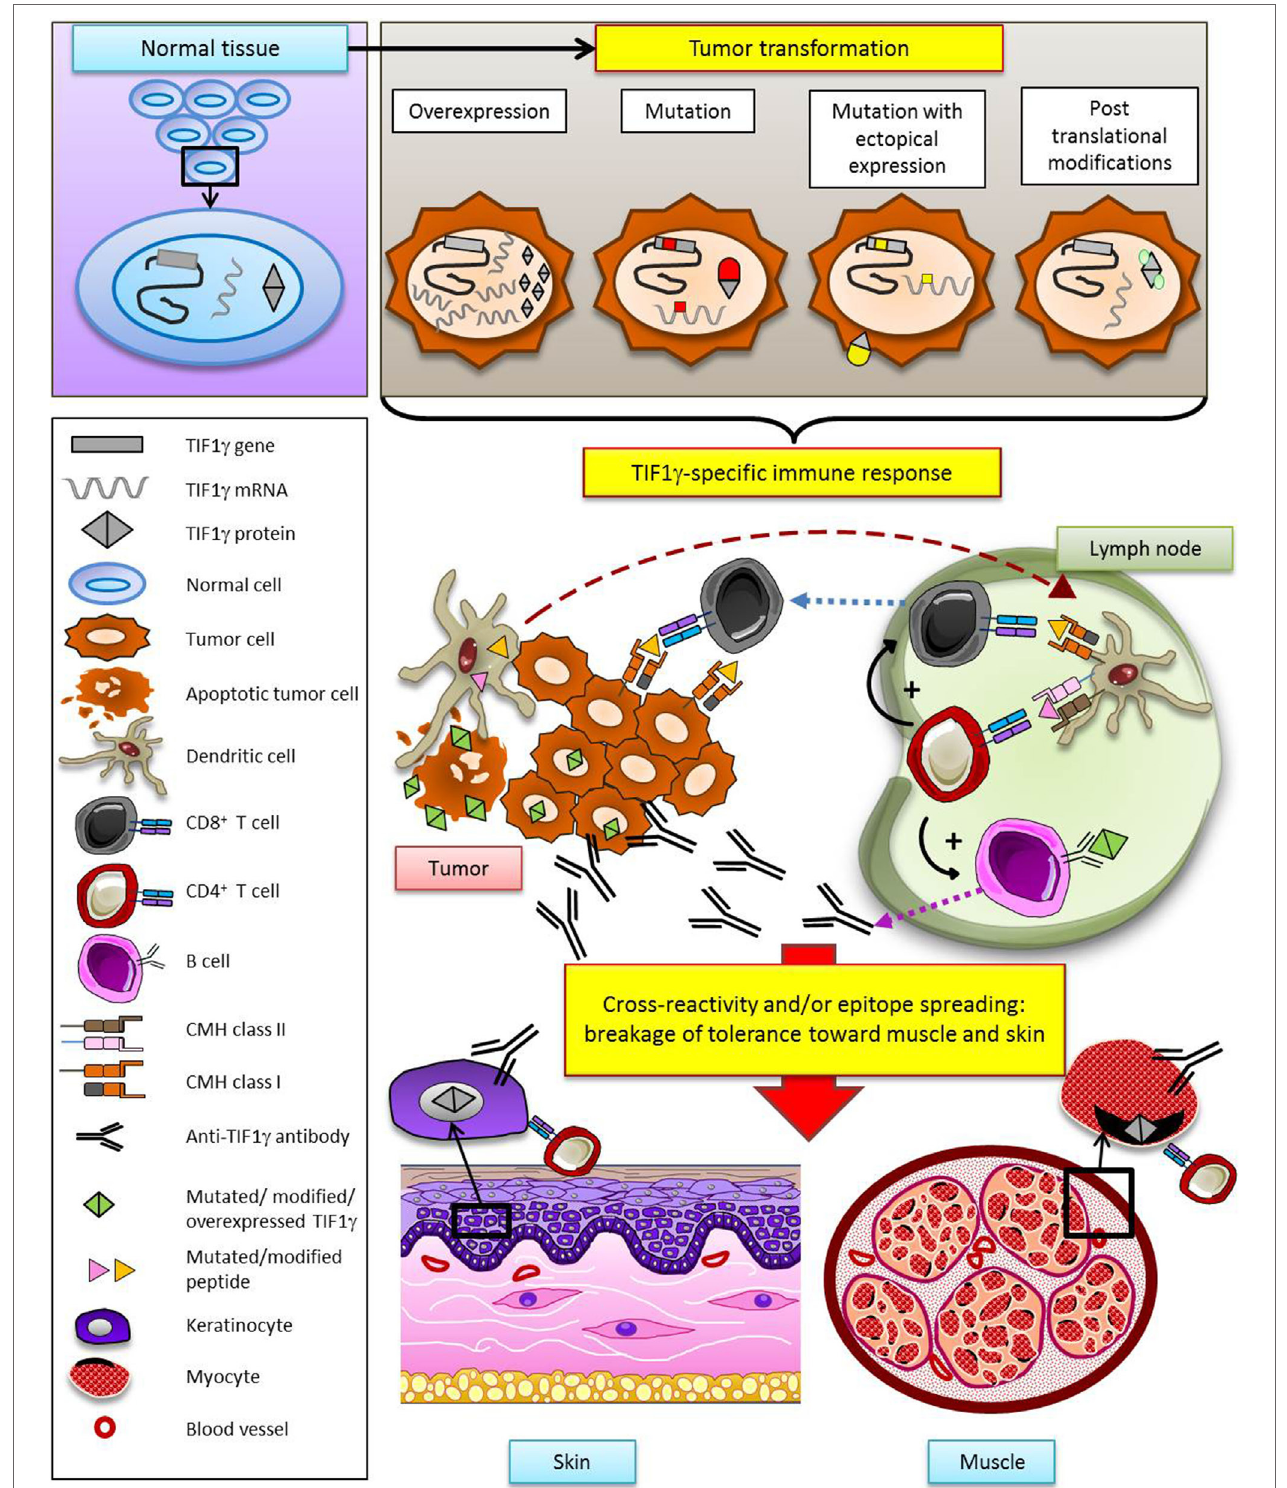
FigURe 3 | Hypothetical model of specific antitumoral response as a trigger of dermatomyositis through the example of TIF1 γ . According to this model, TIF1 γ (or NXP2, or HMGCR) is modified in the tumor (gene mutation, overexpression, ectopic expression, posttranslational modification), leading to the development of a TIF1 γ - (or NXP2-, or HMGCR-) specific T and B cell antitumor response. Secondarily, breakage of tolerance results from cross-reactivity and/or epitope spreading, promoting a response against muscle and